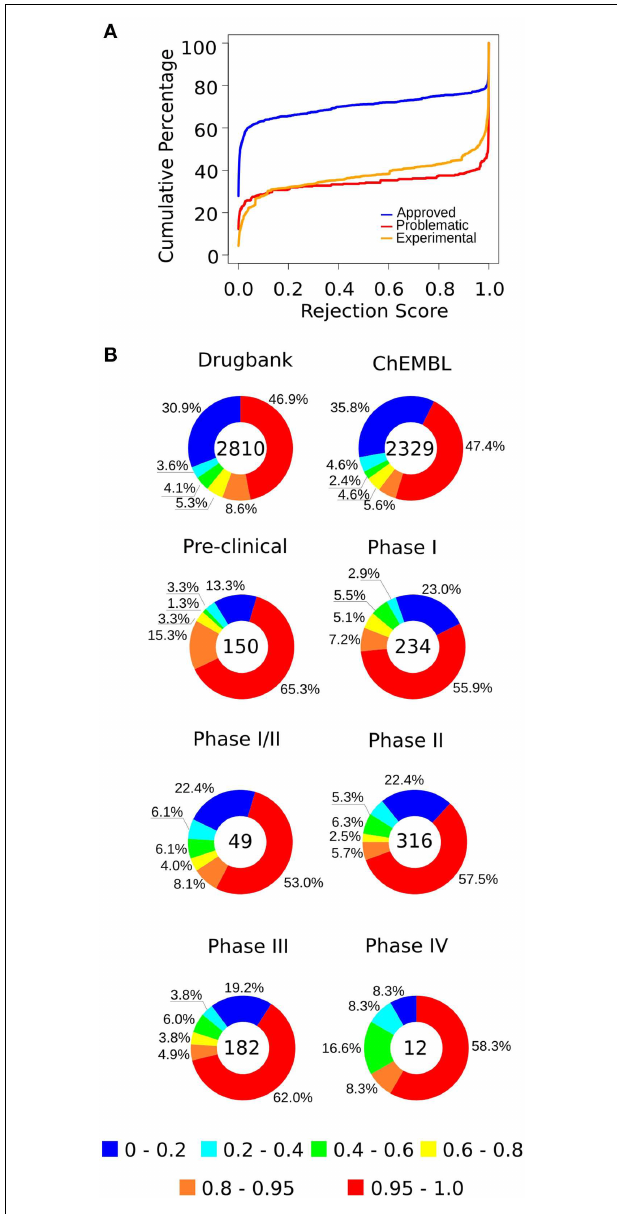
FIGURE 4 | (A) The cumulative percentage of approved, experimental, and problematic drugs, according to their rejection scores (RSs) (the complete predictions are available in Supplementary Tables S3 , S4 ). (B) We predicted the status of experimental drugs from the TTD, Drugbank, and ChEMBL databases. In general, more than half of the drugs have high rejection scores, whereas about 20–30% have RSs that position them among the low-risk compounds. Each chart contains the number of drugs of the respective group.